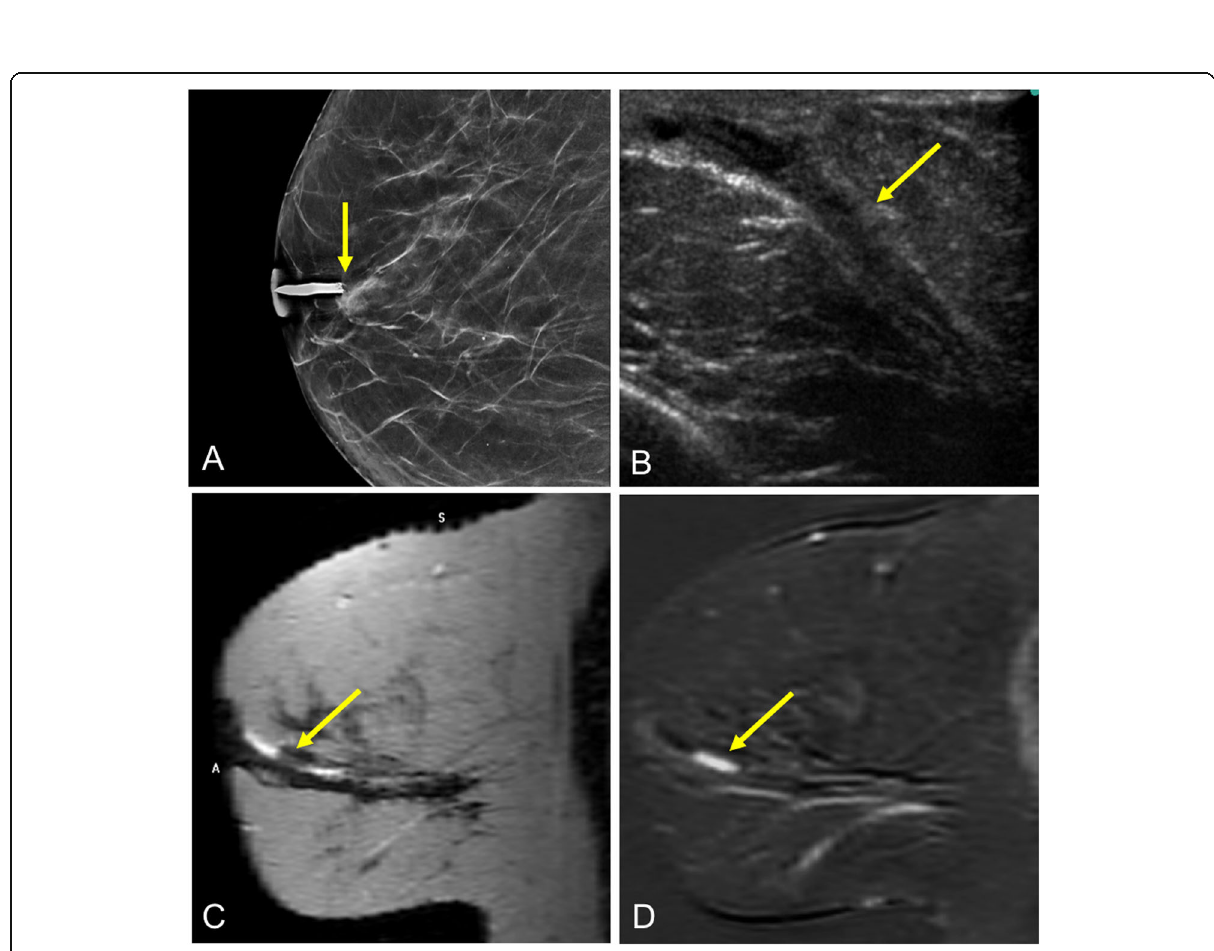
Fig. 16 Ductal cutoff on galactography. A 65-year-old woman with spontaneous bloody discharge from a single orifice in the right breast and negative findings at mammography and ultrasound (images not shown). a Craniocaudal ductogram shows a concave filling defect situated 2 cm behind the nipple. b Ultrasound obtained after galactography shows ductal ectasia with an intraductal lesion (arrow). c Sagittal T2-weighted MRI shows hyperintense ductal ectasia with an intraductal mass, which on ( d ) sagittal contrast-enhanced T1-weighted MRI (subtracted image obtained 120 s after contrast injection) corresponds to a mass with differential contrast enhancement (arrow). Histologic study: solitary intraductal